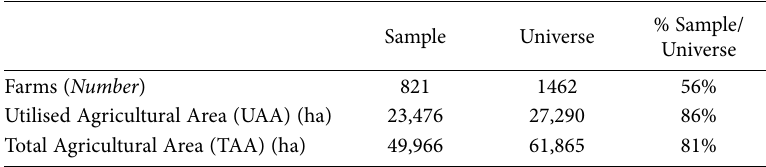
Table 1. Mugello - Coverage of the farms sample compared to universe provided by 2010 Agricultural